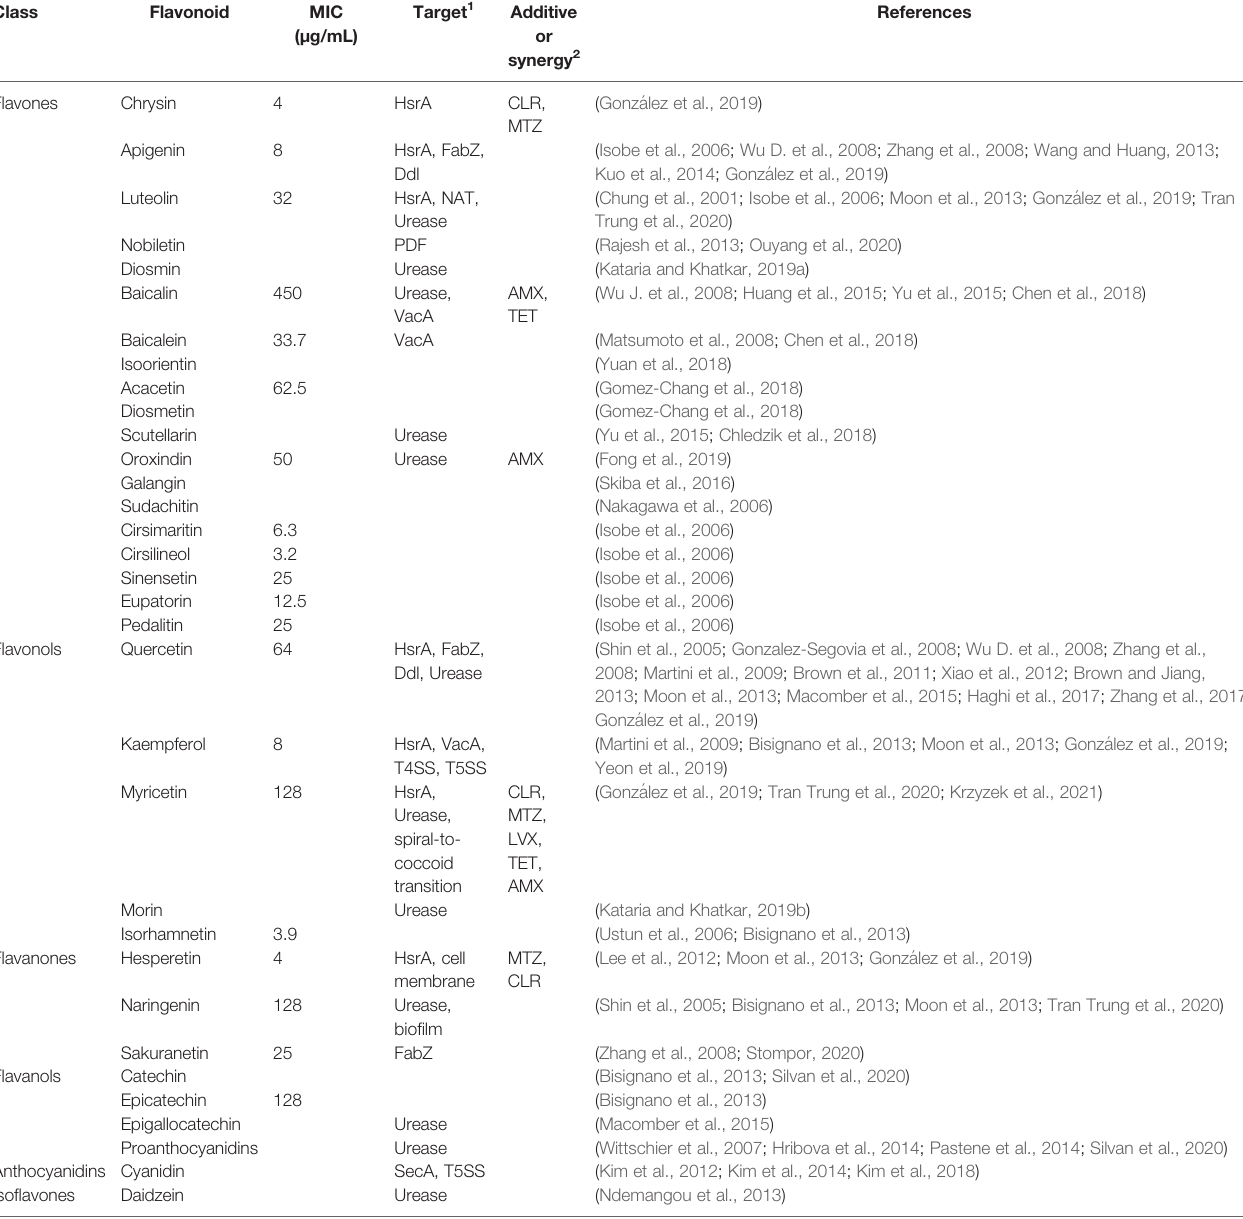
TABLE 2 | Natural fl avonoids with antimicrobial activities against H. pylori